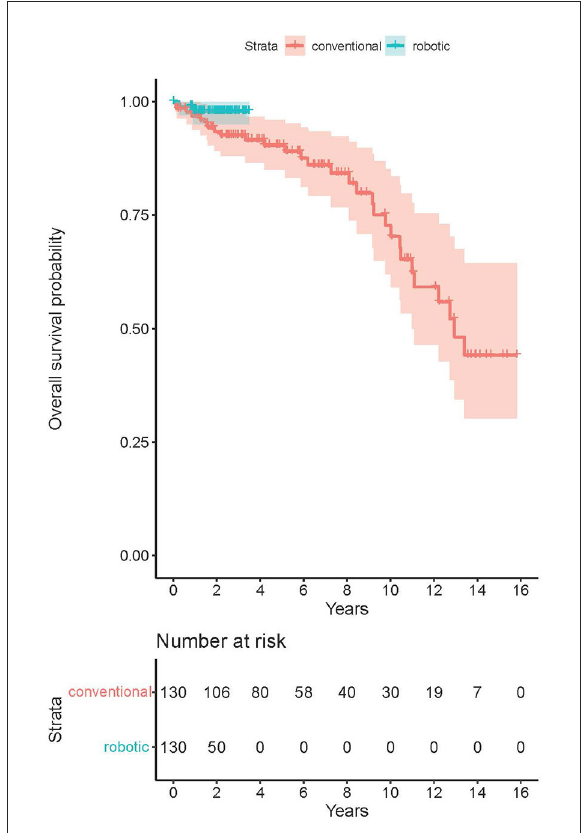
FIGURE2 Kaplan-Meier survival analysis of the conventional and robotic MIDCAB